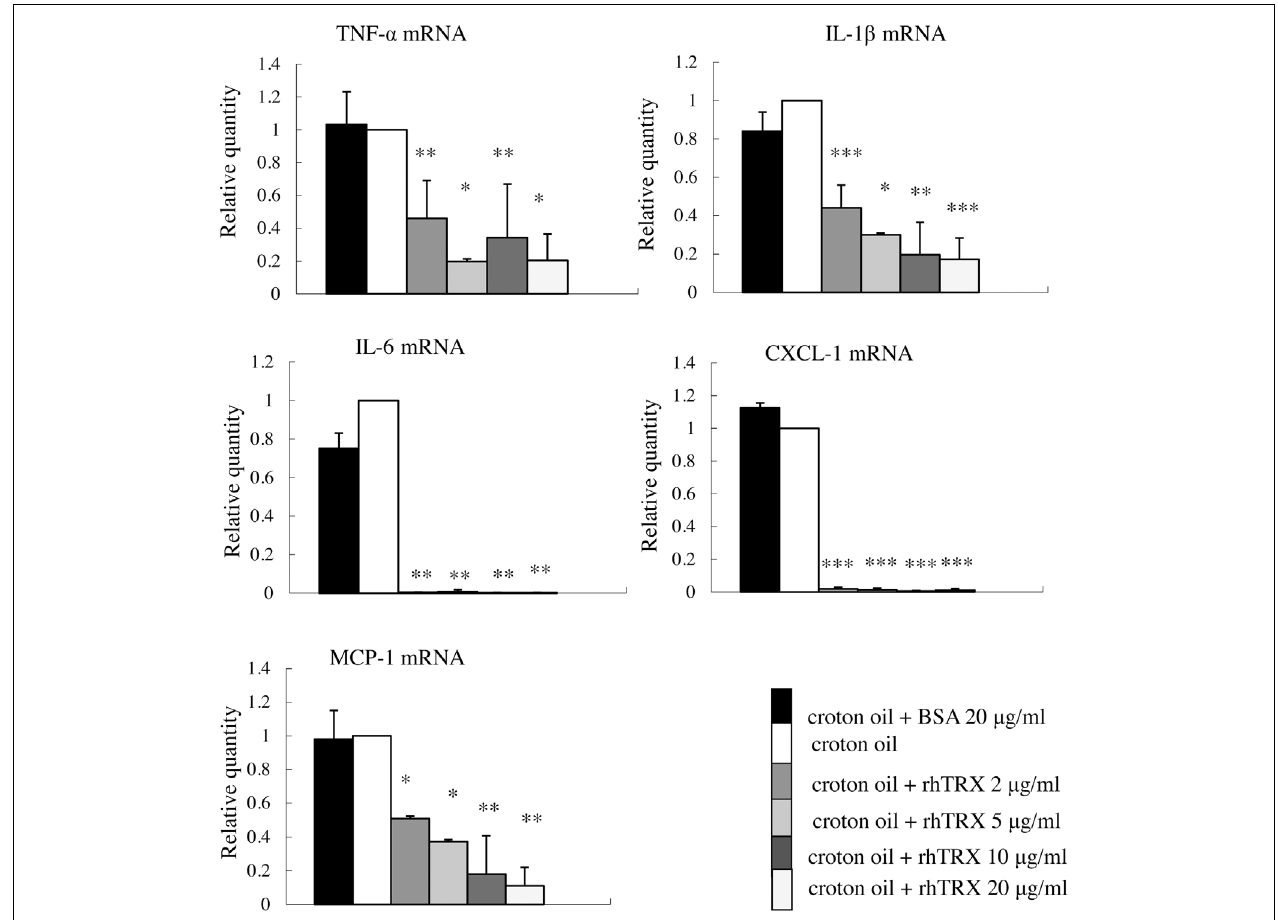
stimulation.The mRNA expression in the rhTRX treatment group was significantly suppressed by 2–20 µ g/ml rhTRX, compared with the BSA treatment groups.The mRNA expression levels were determined relative to croton oil-stimulated cells.Values are shown as the mean ± SD of